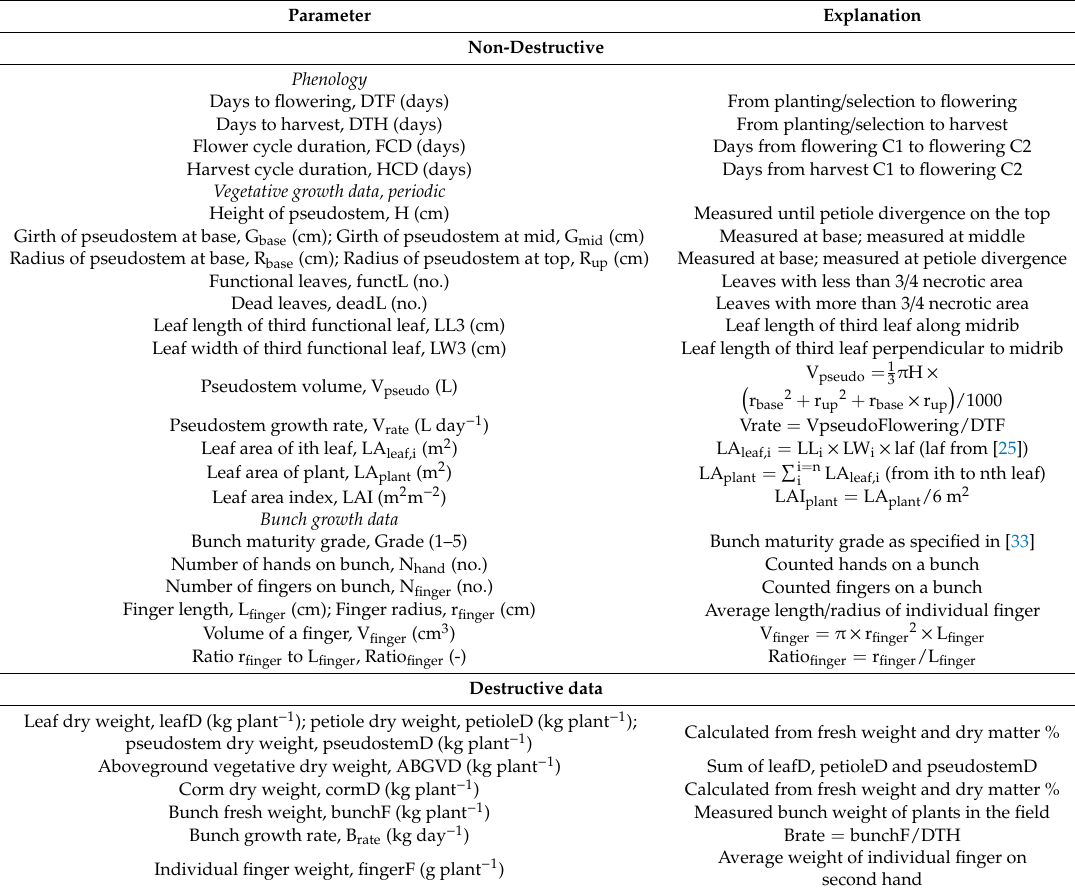
Table 1. Growth data measured. Non-destructive data includes phenological data collected for the individual plants on a mat, vegetative growth data measured monthly at the plot level on all plants on a mat and at harvest / destructive sampling of a plant, and bunch data measured on harvest ready plants. Destructive data includes biomass data that was determined destructively at harvest or during periodic destructive sampling. Parameter Explanation Non-Destructive Phenology Days to flowering, DTF (days)